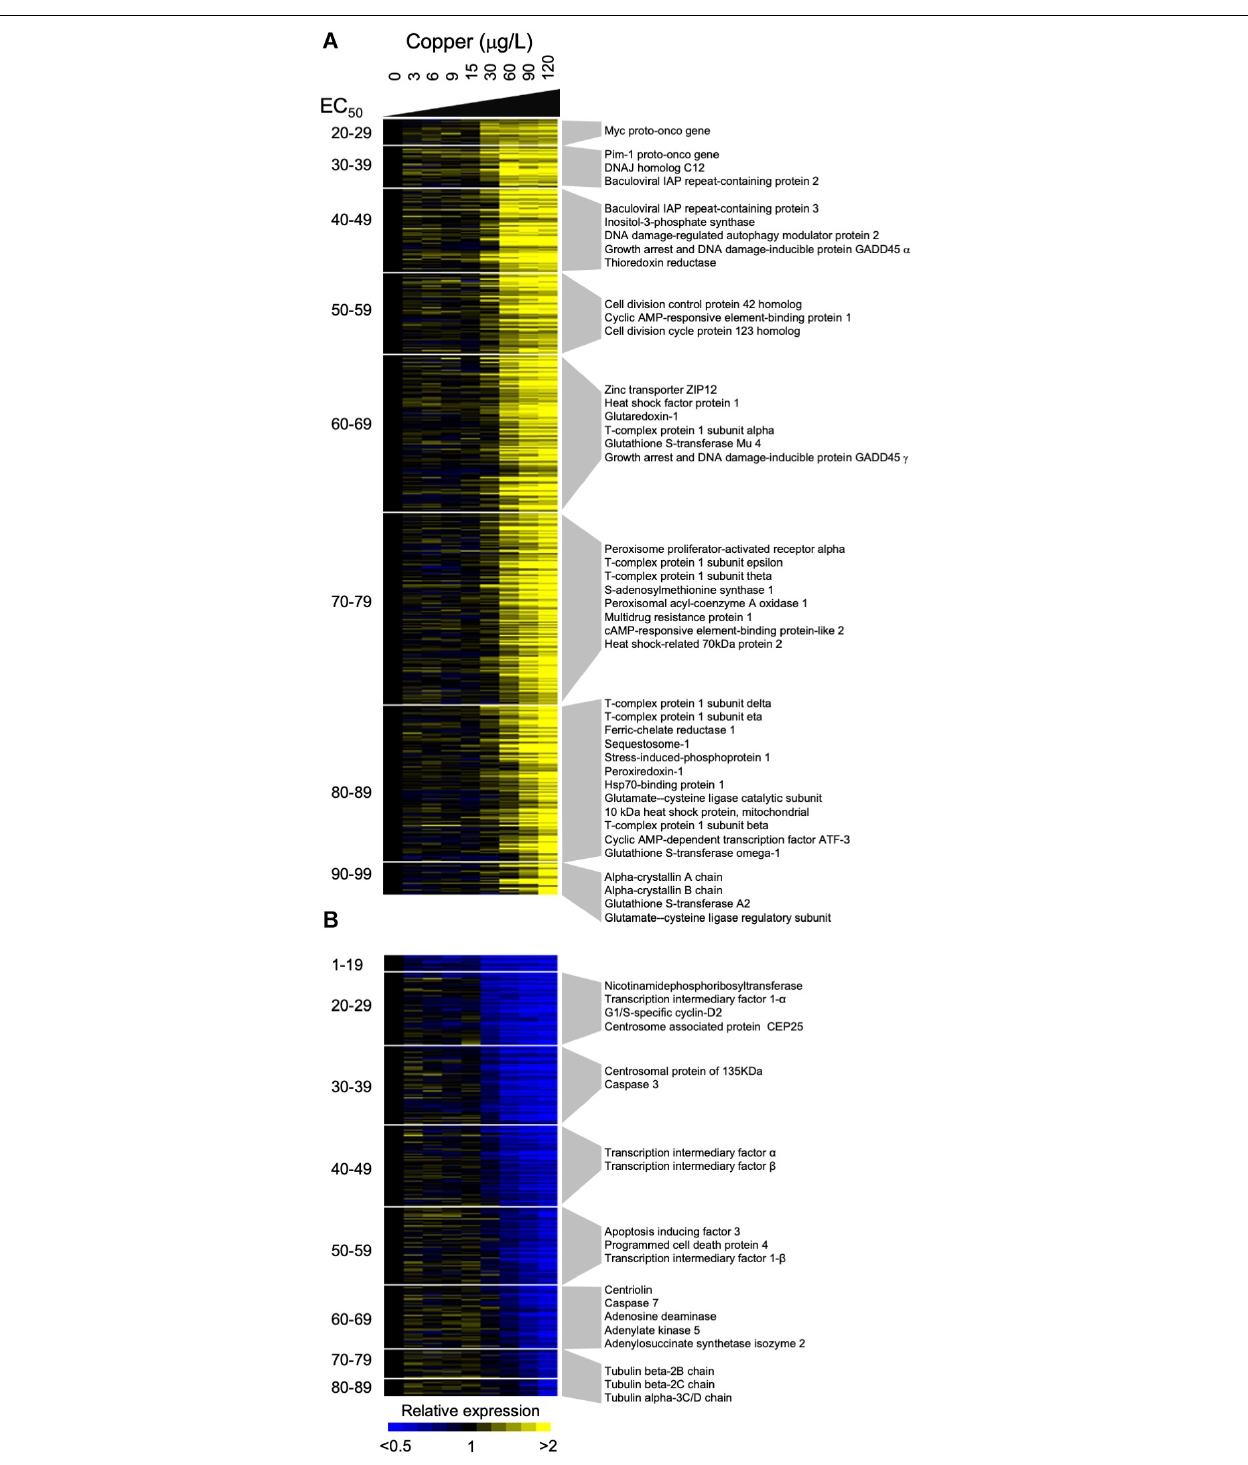
Frontiers in Marine Science |